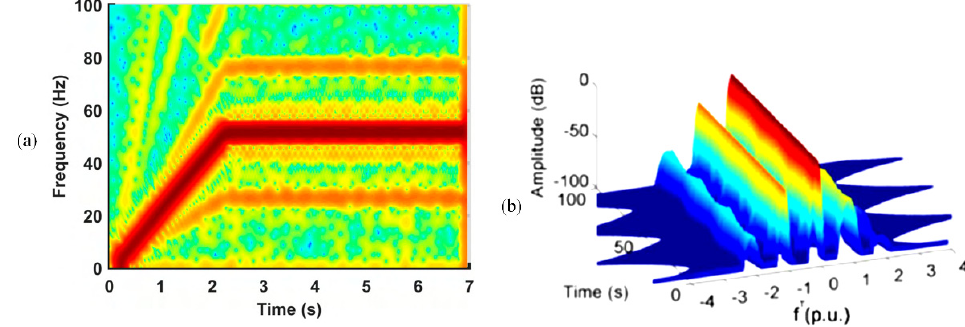
Figure 5. ( a ) Typical time-frequency spectrogram for eccentricity diagnostics [101]. ( b ) Time-frequency pattern of OT analysis for eccentricity diagnostics [112]. Table 2. Summary of signal processing techniques for eccentricity diagnosis.